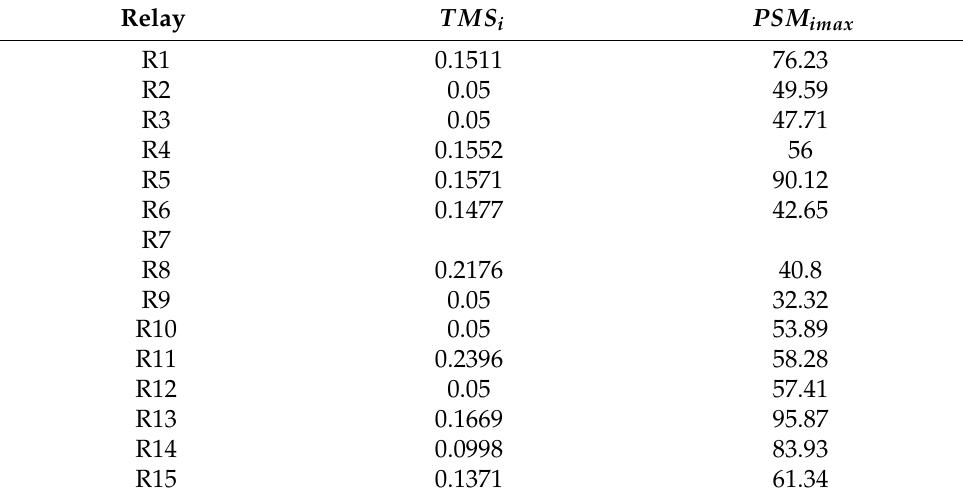
Table 9. Coordination parameters for Scenario 4.